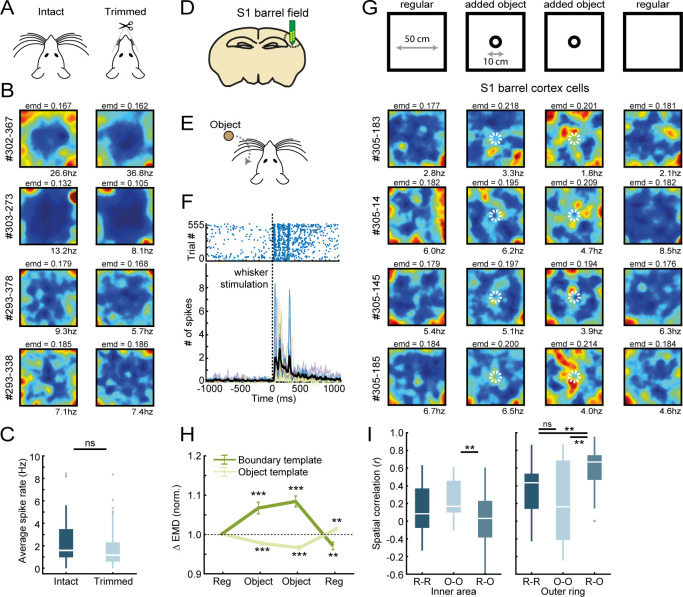
Control experiments to assess the role of somatosensory information in computing border information.(A) Whiskers of rats were trimmed to the skin on the final recording day, with one behavioral session before and after trimming for each animal. (B) Example rate maps of RSC border cells before (left column) and after trimming (right column), with four examples of cells that were unaffected by trimming and maintained their boundary tuning the in absence of whiskers. No significant changes were observed in the proportion of border cells due to whisker trimming. (C) Whisker trimming had no significant effect on the overall firing rates of RSC border cells. (D) Recordings were performed from neurons in the barrel field of the primary somatosensory cortex (S1bf) by implanting a 64-channel silicon probe. (E) In an anesthetized preparation, an object (sandpaper) was moved through the whiskers contralateral to the recorded hemisphere at 10 s intervals. The silicon probe was lowered until a substantial number of cells responded consistently to the whisker stimulation. (F) A subset of neurons fired reliably after whisker stimulation. Top: example raster plot of spikes from a representative whisker-responsive cell. Bottom: number of spikes for individual neurons (colored lines) and the population-average (black line) shows that neurons fired 30–500 ms after the object moved through the whiskers. (G) Recordings were performed across four behavioral sessions, with an object introduced to the maze in the middle two sessions. Shown are rate maps of four example cells recorded from S1 barrel cortex that matched our border cell criteria, where cells fired around the edges of the arena but also formed firing fields around the object. (H) EMD scores confirm that S1bf cells fired around objects, as the boundary EMD scores increased significantly in the object session, while the object template EMD scores decreased accordingly. (I) Spatial correlations between rate maps of regular and object sessions decreased significantly when comparing the inner area of the rate map, consistent with the formation of firing fields around the object. **p<0.01, ***p<0.001, Wilcoxon signed-rank test.